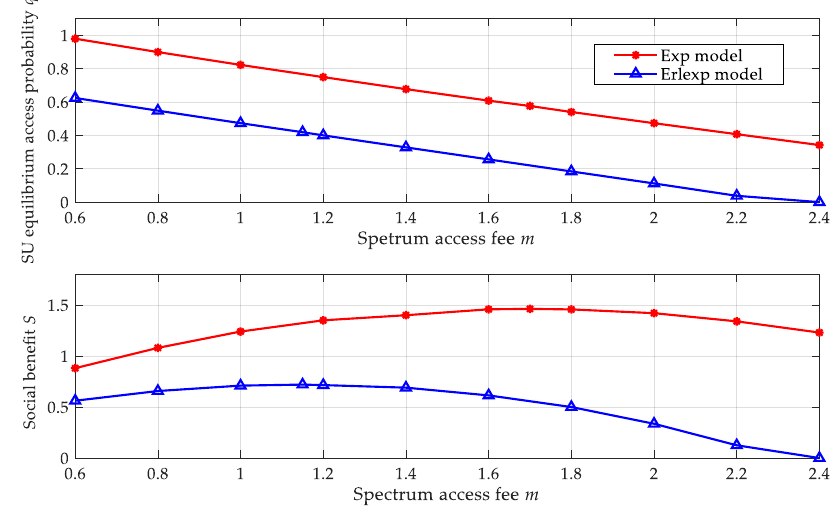
Figure 2. The impact of spectrum access fee m on the social benefit S and the SU equilibrium access probability q e .